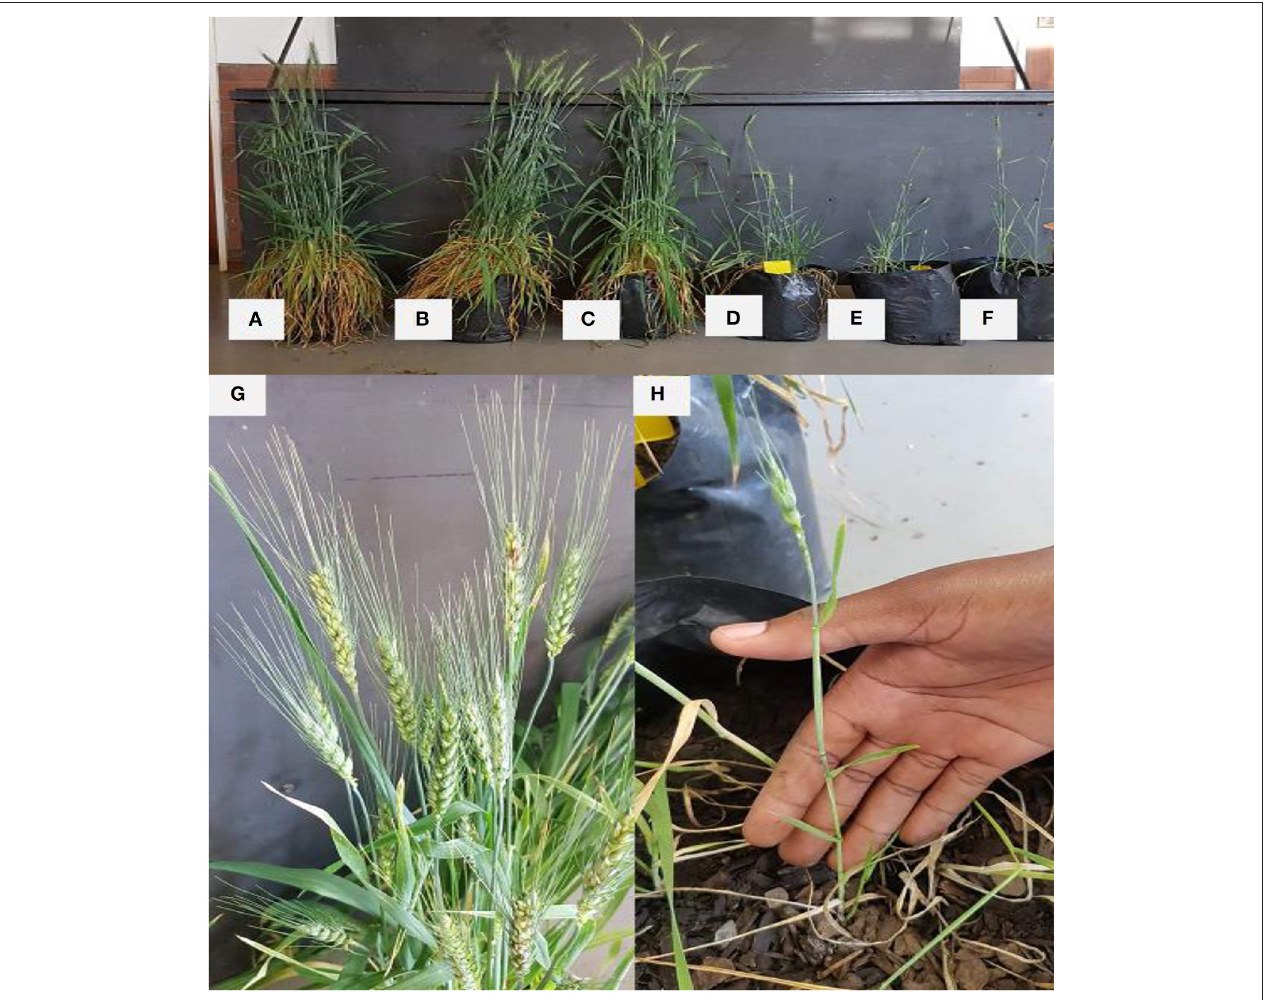
FIGURE 8 | Variation in plant height and shoot biomass production among M 3 wheat populations. (B,G) (Population 1), (C,D) (Population 2), (E,F,H) (Population 3), and (A)